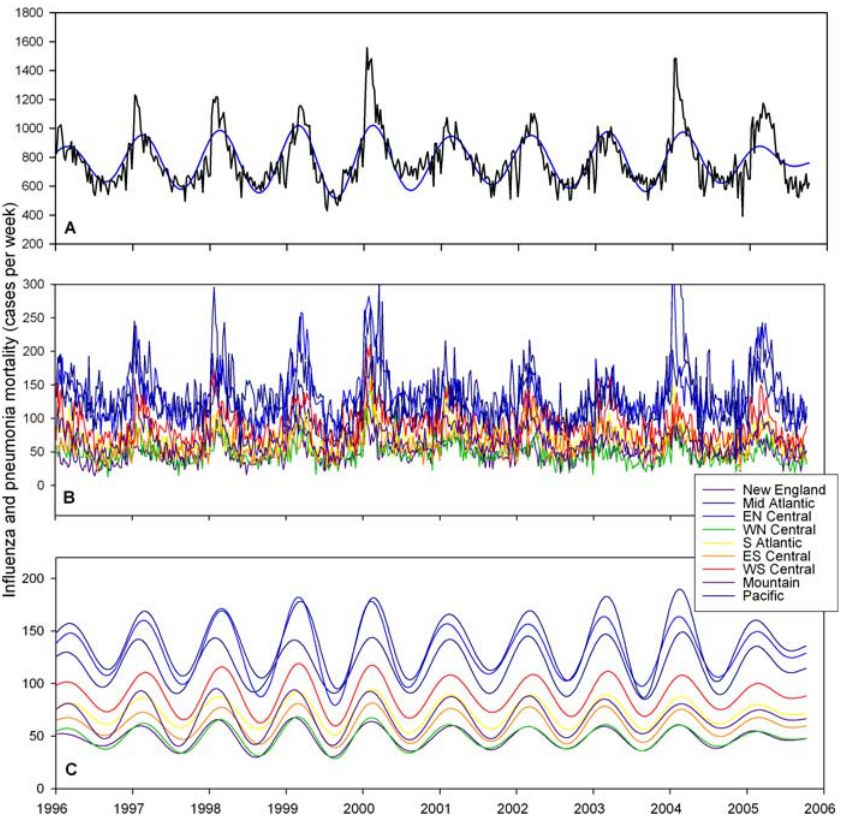
Figure 1. Filtering of Weekly P&I Mortality in the United States (1996–2005) (A) The black line represents the aggregated national data of P&I weekly mortality. The blue line represents the seasonal influenza curve, derived by band-pass filtering the demeaned data (two-pole, two-pass Butterworth, 1/64–1/40 frequency range). For comparison with the raw data, the mean is added after filtering. The filtered time series plus mean accounts for 99.8% of the mortality, indicating that most deaths are from the mean and seasonal variation and not the high-frequency cycles. (B) Lines represent the raw time series data for each of the nine geographic regions of the US. (C) Lines represent the seasonal influenza curves for each of the nine geographic regions of the US, derived by band-pass filtering. DOI: 10.1371/journal.pmed.0030401.g001 PLoS Medicine |